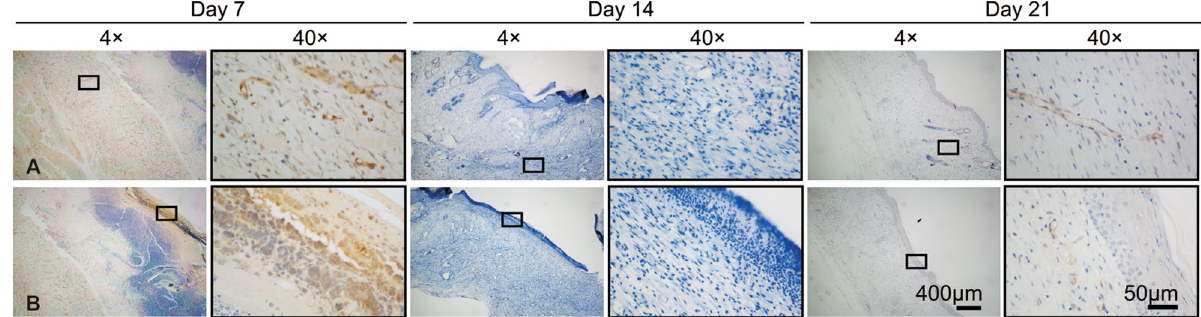
Figure 6. Representative immunohistochemical staining images of CD31 on ( A ) dermis and ( B ) epidermal layer on days 7, 14 and 21 in rcBCS